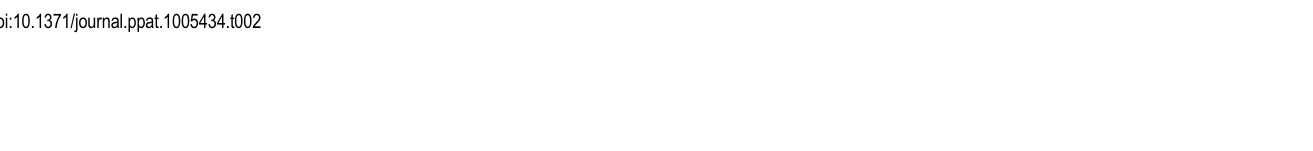
CI was determined by quantifying viable eggs resulting from a series of crosses between Wolbachia infected and wild type mosquitoes. Mean hatching rates are reported and standard error of the mean is